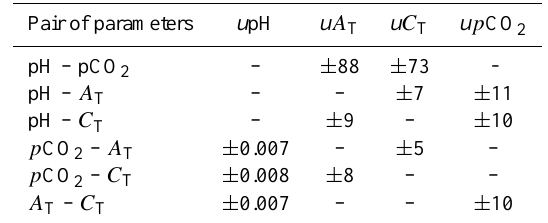
Table 5. Relative uncertainties in pH, total alkalinity ( A T